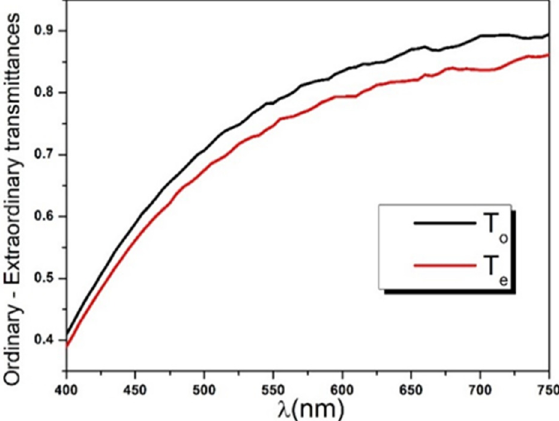
Figure 8. Ordinary and extraordinary intensity transmittances of Mylar sample obtained using Equation (31).